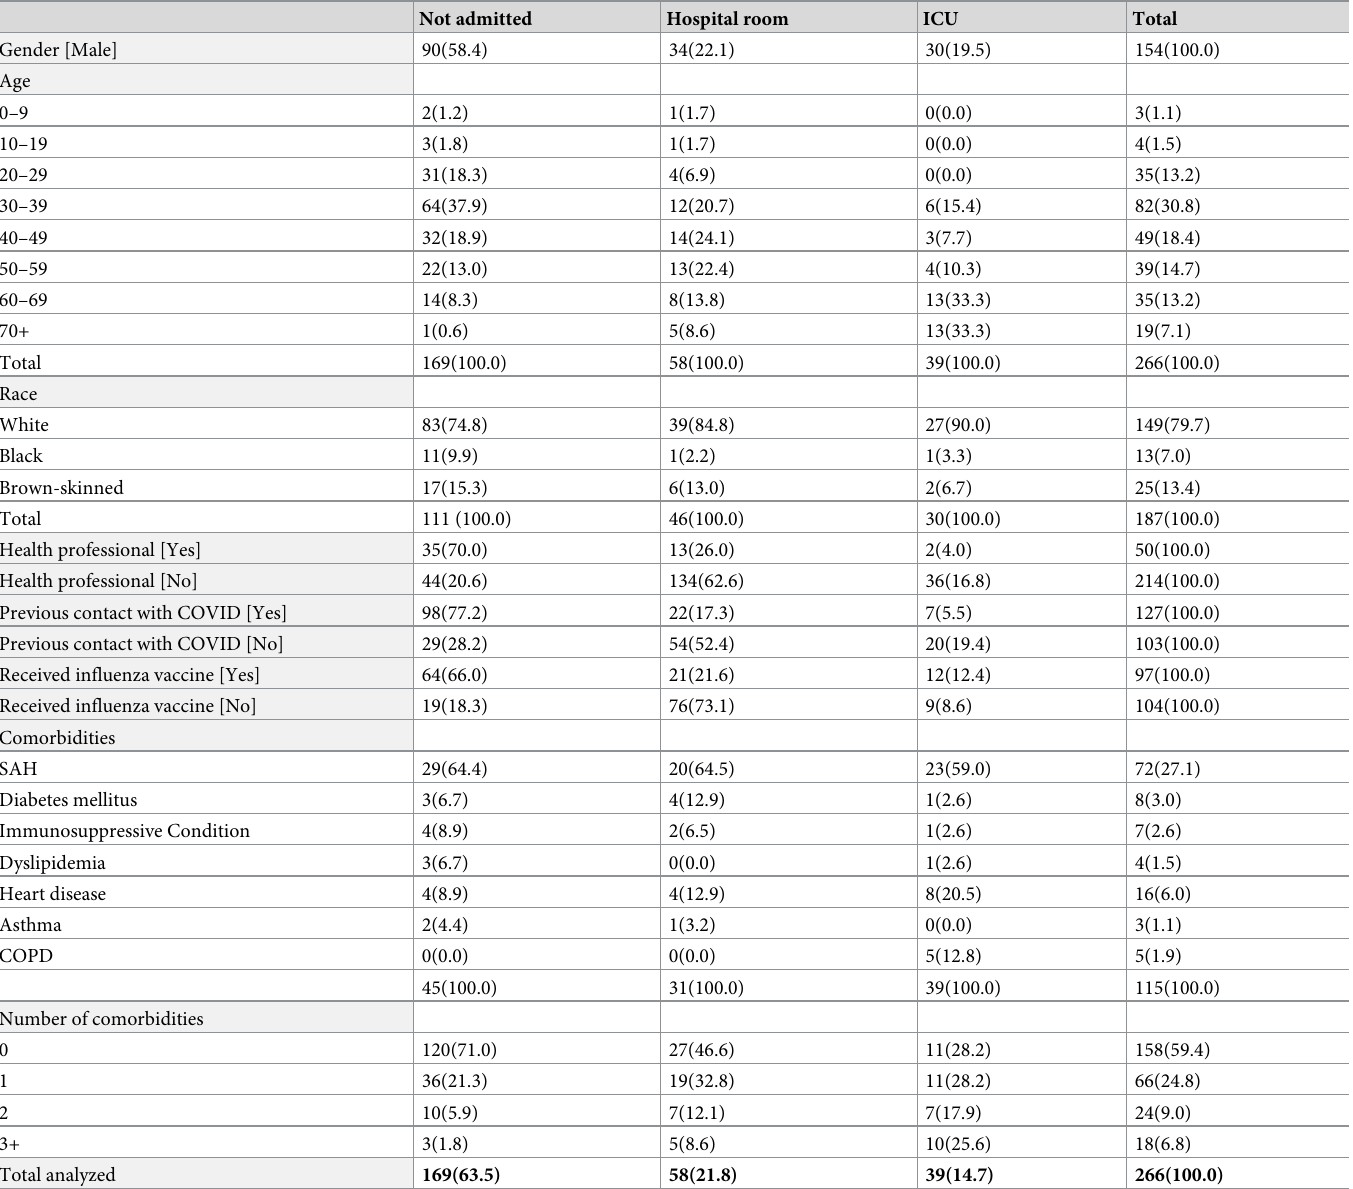
Table 1. Epidemiological data of the sample separated by